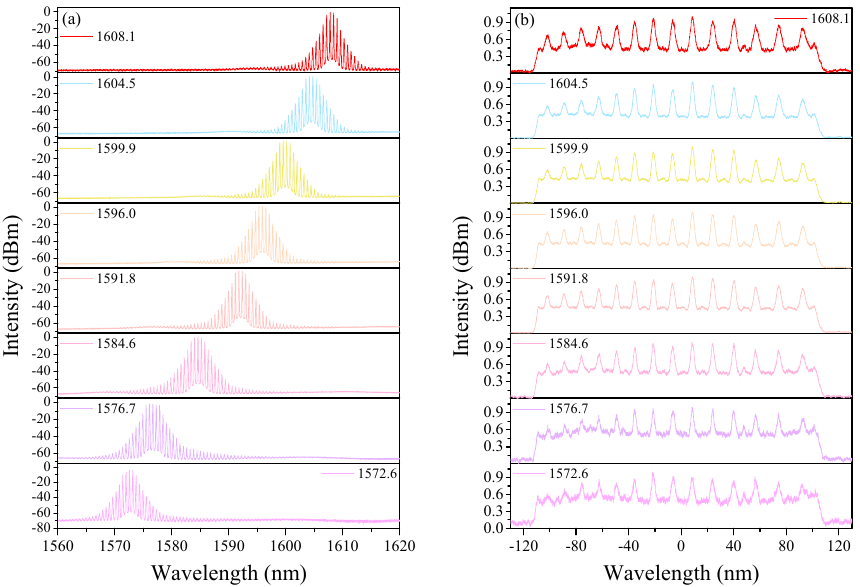
Figure 8. HRR single-soliton train for different polarization states when the length of intra-cavity PMF is 10 m. ( a ) Optical spectra at various central wavelengths. ( b ) Corresponding AC traces.